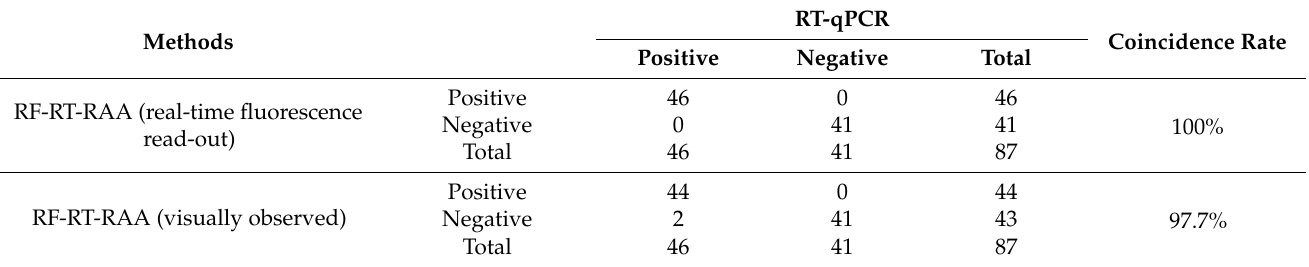
Table 3. Clinical performance of RF-RT-RAA for PRRSV-2 detection compared with